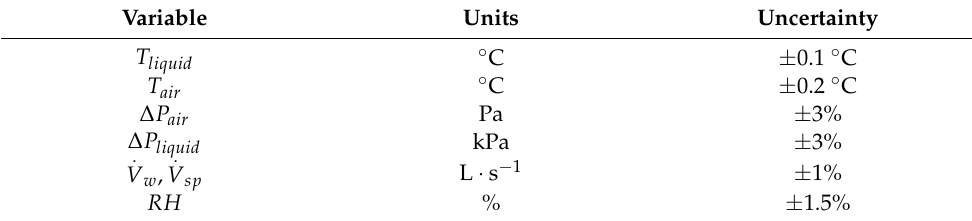
Table 1. Measured variables and their experimental